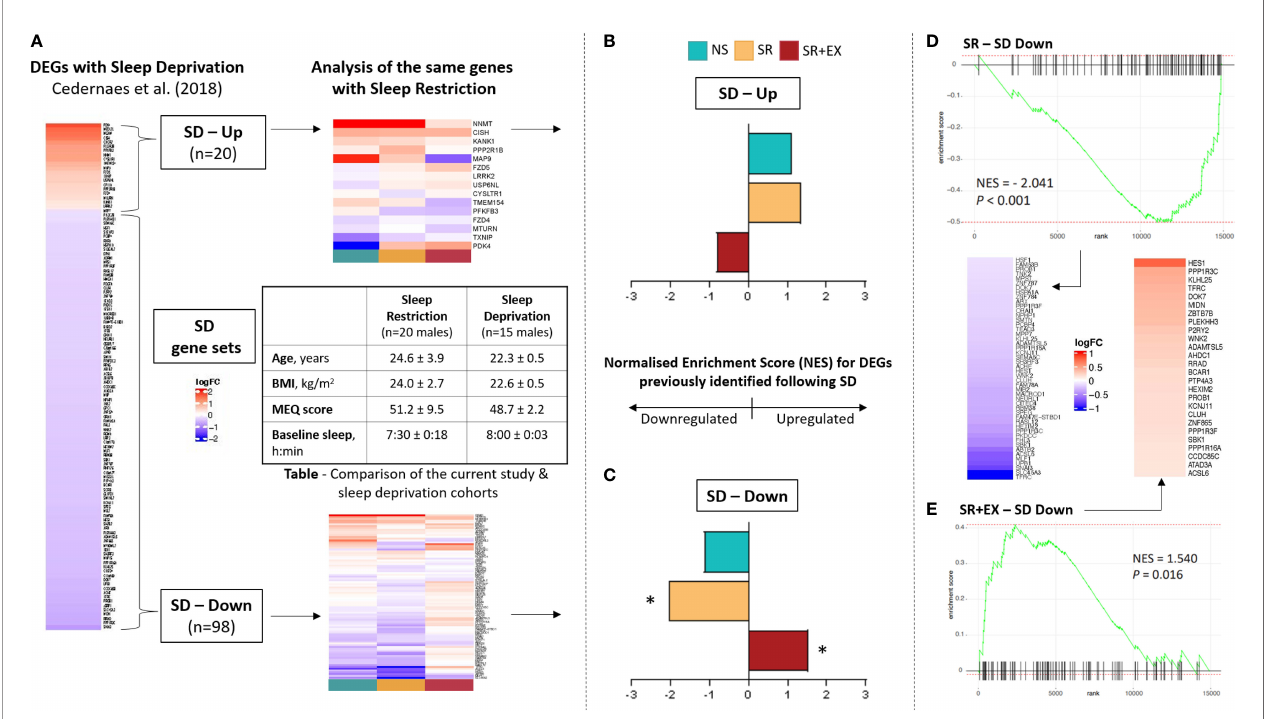
FIGURE 3 | Comparison of our data set with previously reported transcriptional changes following 24 hours of sleep deprivation (13). (A) Overview of analysis work fl ow: two gene sets were created based on 1) Up-regulated and 2) Down-regulated genes in skeletal muscle following 24 h of sleep deprivation (SD) (created gene sets labelled as SD – Up and SD – Down, respectively). The enrichment of genes comprising SD-Up and SD-Down were then assessed in the current study cohort. Normalised enrichment score (NES) of our data set compared to the (B) SD – Up and (C) SD - Down gene sets. Rank and enrichment score of the SD - Down gene set in the (D) SR group and (E) SR+EX group, as well as heatmaps of leading-edge genes. Normal Sleep (NS), Sleep Restriction (SR), Sleep Restriction and Exercise (SR+EX), morningness-eveningness questionnaire score (MEQ score), differentially expressed genes (DEGs). *Denotes signi fi cant enrichment (adjusted P value